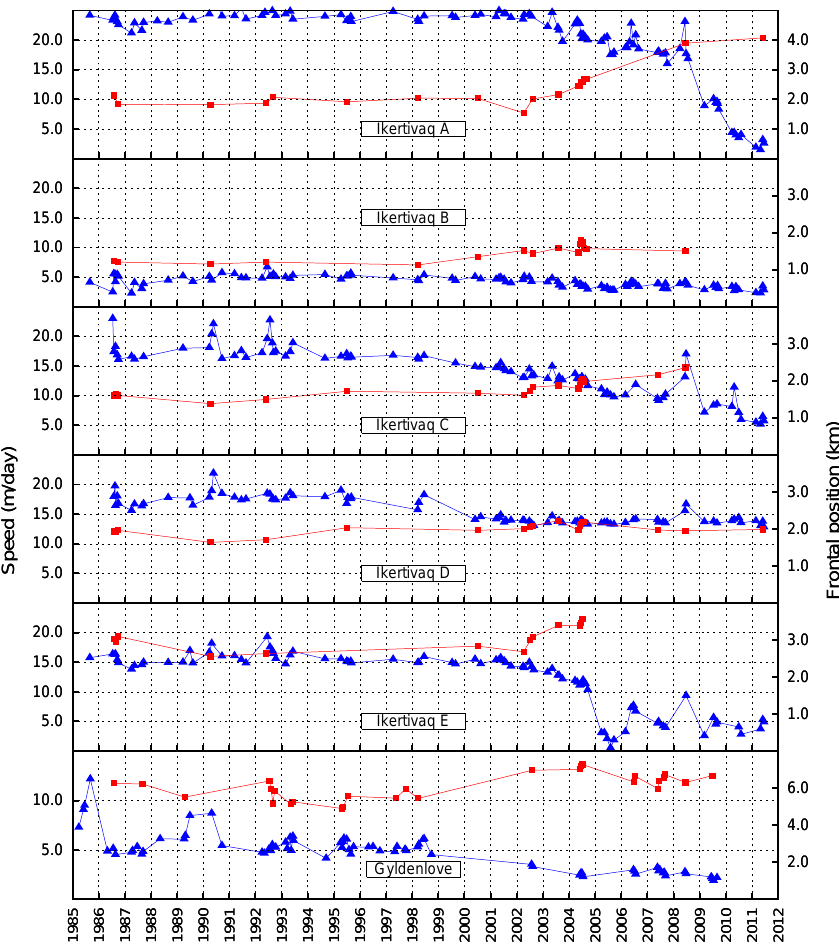
Fig. 5. Surface flow speeds (red squares) and frontal positions (blue triangles) for the Ikertivaq and Gyldenlove glaciers (see Fig. 1 for